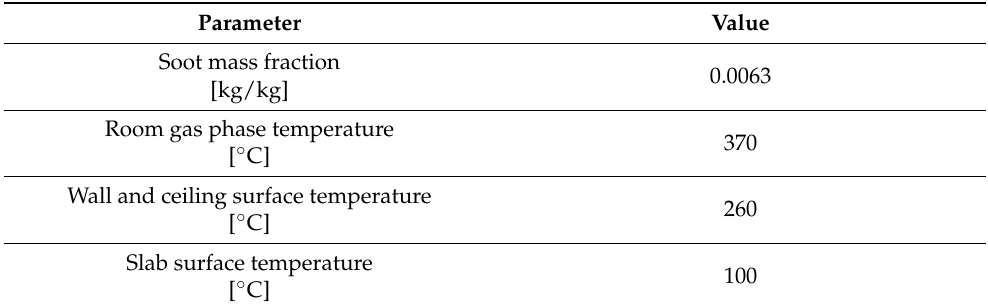
Table 5. Parameters adopted for the compressed timelines, applied for the entire initial region or boundary